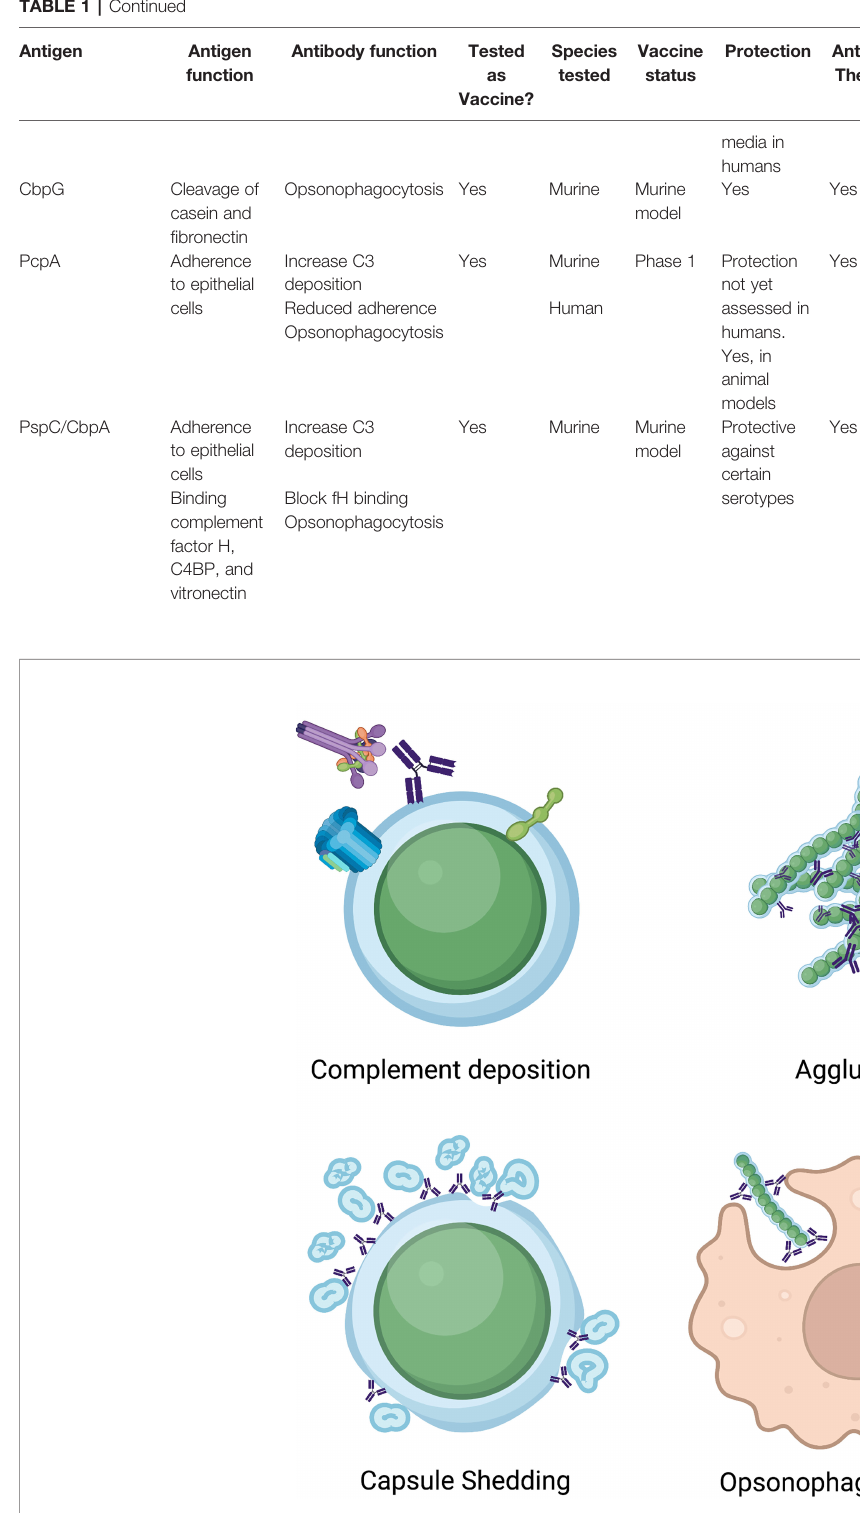
FIGURE 2 | Illustration of mechanisms of anti-pneumococcal antibodies. Antibodies binding pneumococcal antigens can increase complement deposition, leading to formation of the membrane attack complex, induce bacterial agglutination, cause capsule shedding, and increase opsonophagocytic activity of phagocytic